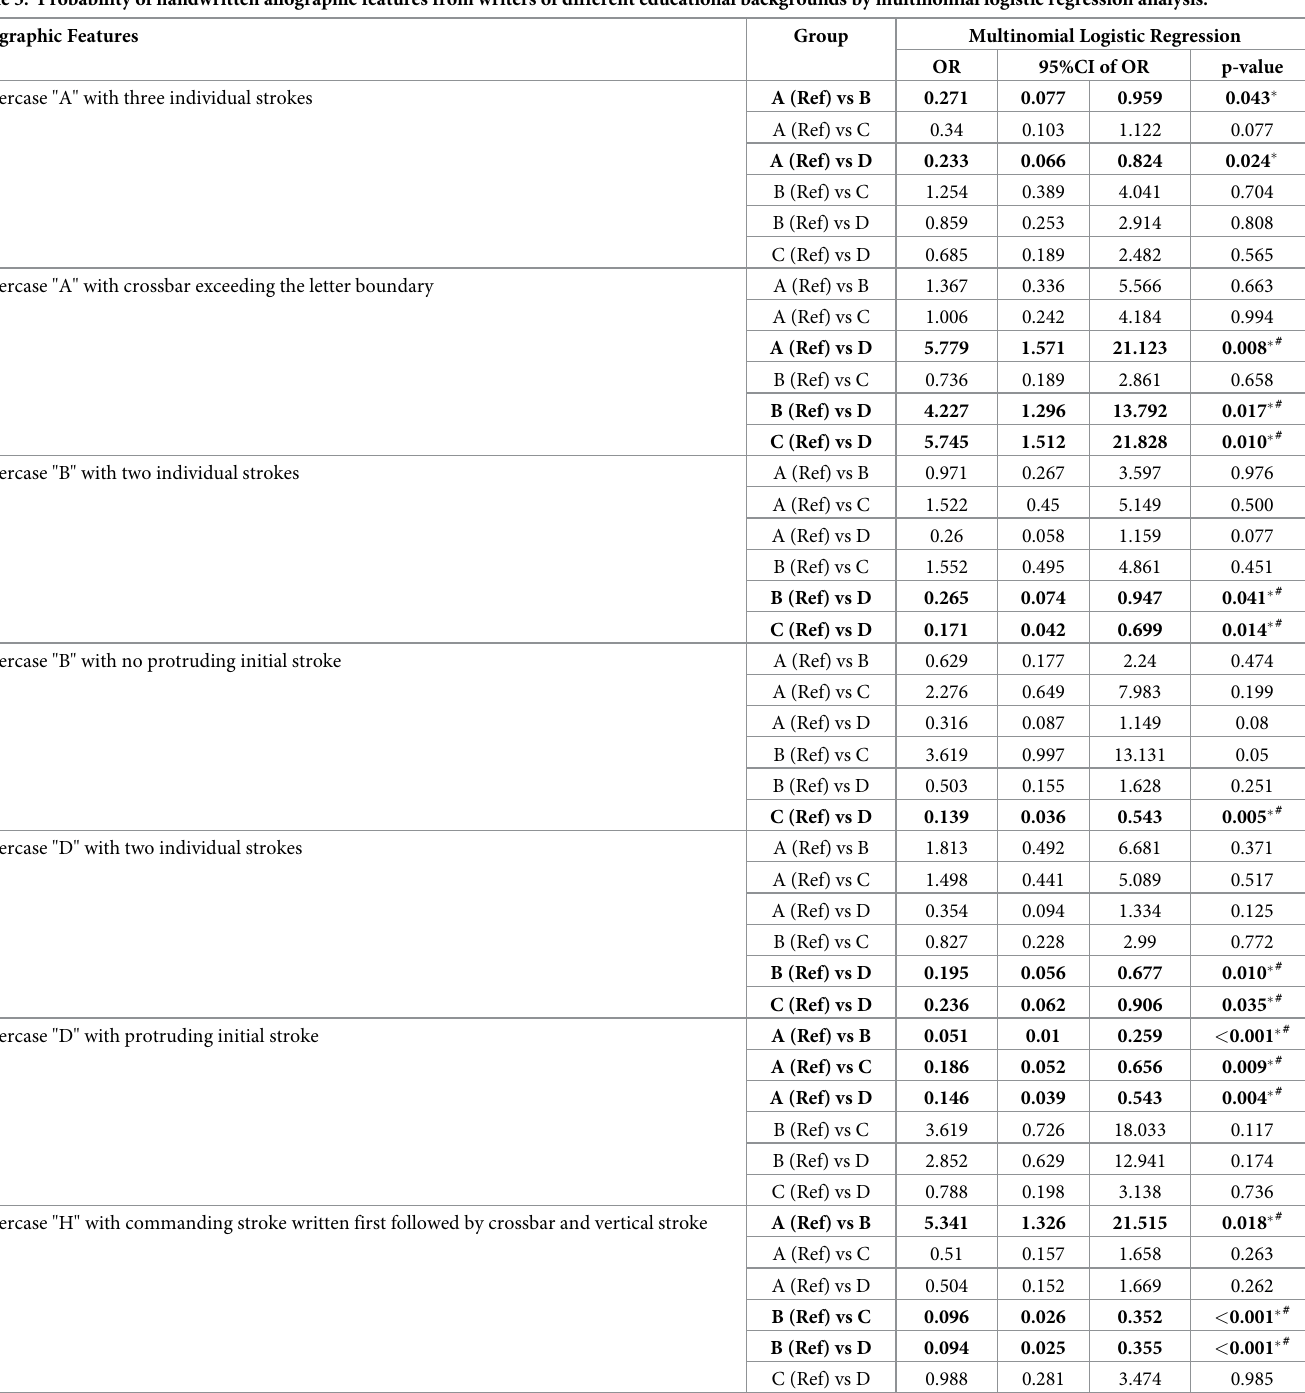
Table 3. Probability of handwritten allographic features from writers of different educational backgrounds by multinomial logistic regression